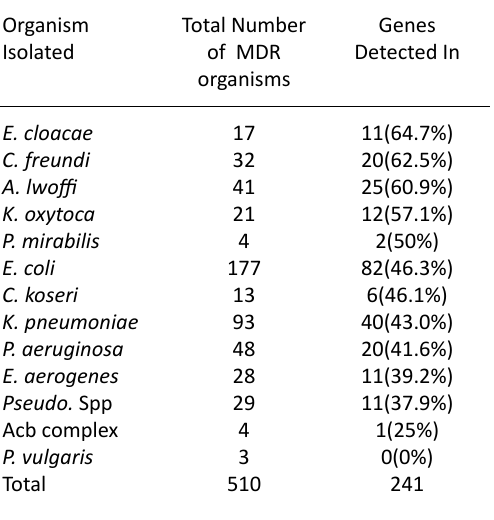
Table 6. Species wise distribution of Gene detected in number of MDR